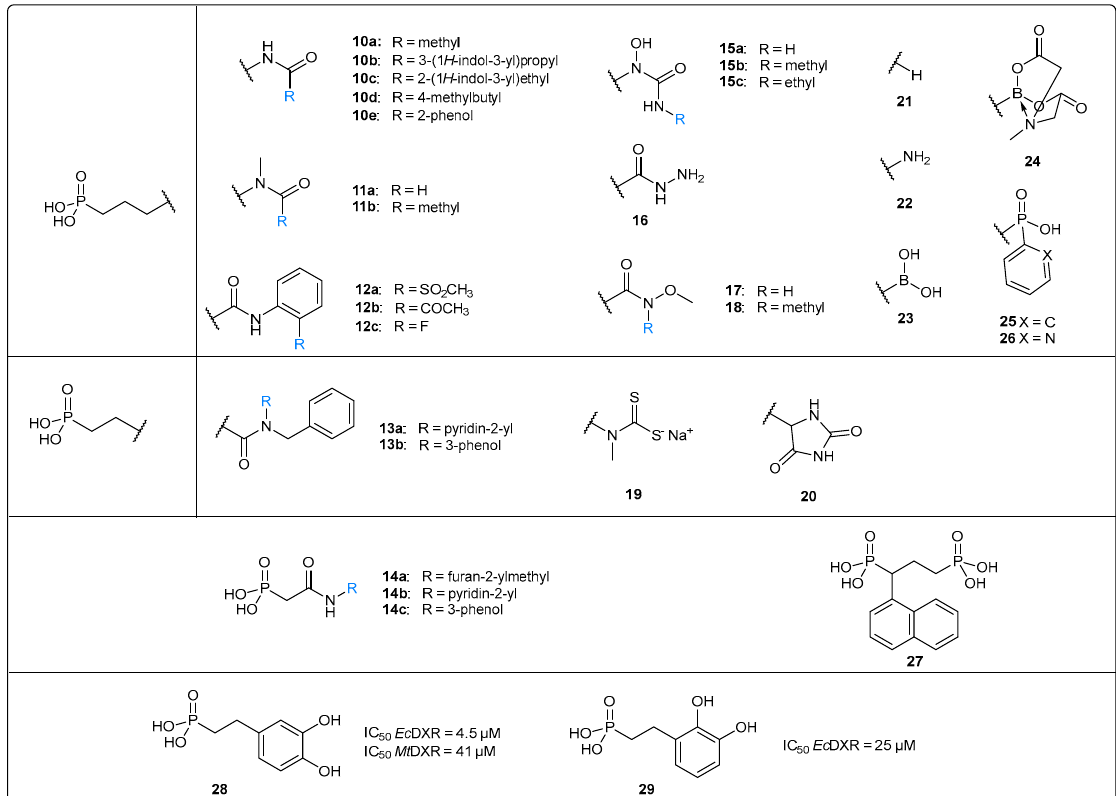
Figure 11. Structures and biological activities of analogs 10 – 29 with alternative chelating functionalities.